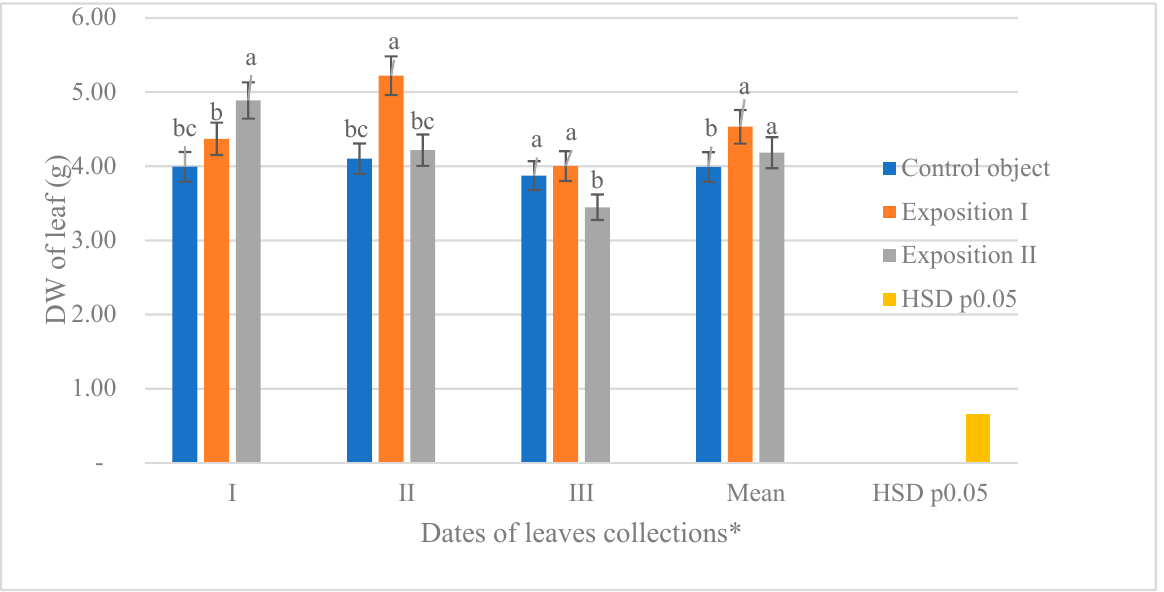
Figure 7. The effect of seed stimulation and harvest time on the mass of the 5th leaf (g) (2015–2017).